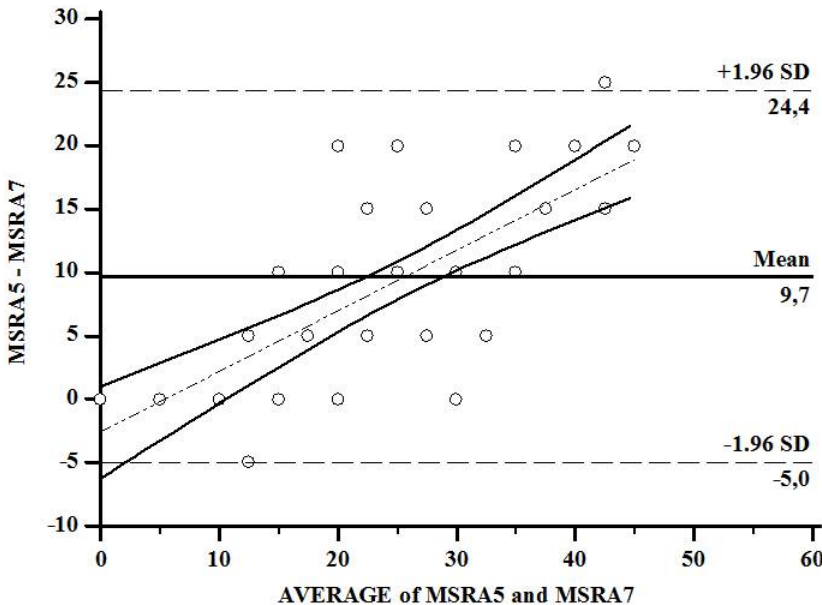
Figure 3. Bland–Altman coefficient analysis between MSRA-7 (full version) and -5 (short version) items. MSRA: Mini Sarcopenia Risk Assessment questionnaire.